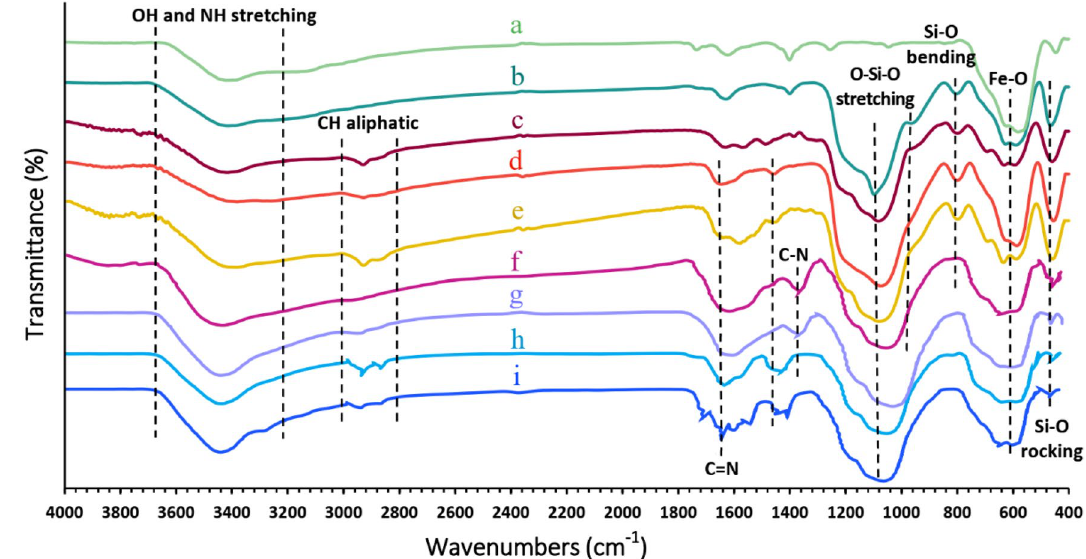
Figure 2. FT-IR spectra of Fe 3 O 4 ( a ), Fe 3 O 4 @SiO 2 ( b ), Fe 3 O 4 @SiO 2 -PrNH 2 ( c ), Fe 3 O 4 @SiO 2 -TzCl 2 ( d ), Fe 3 O 4 @ SiO